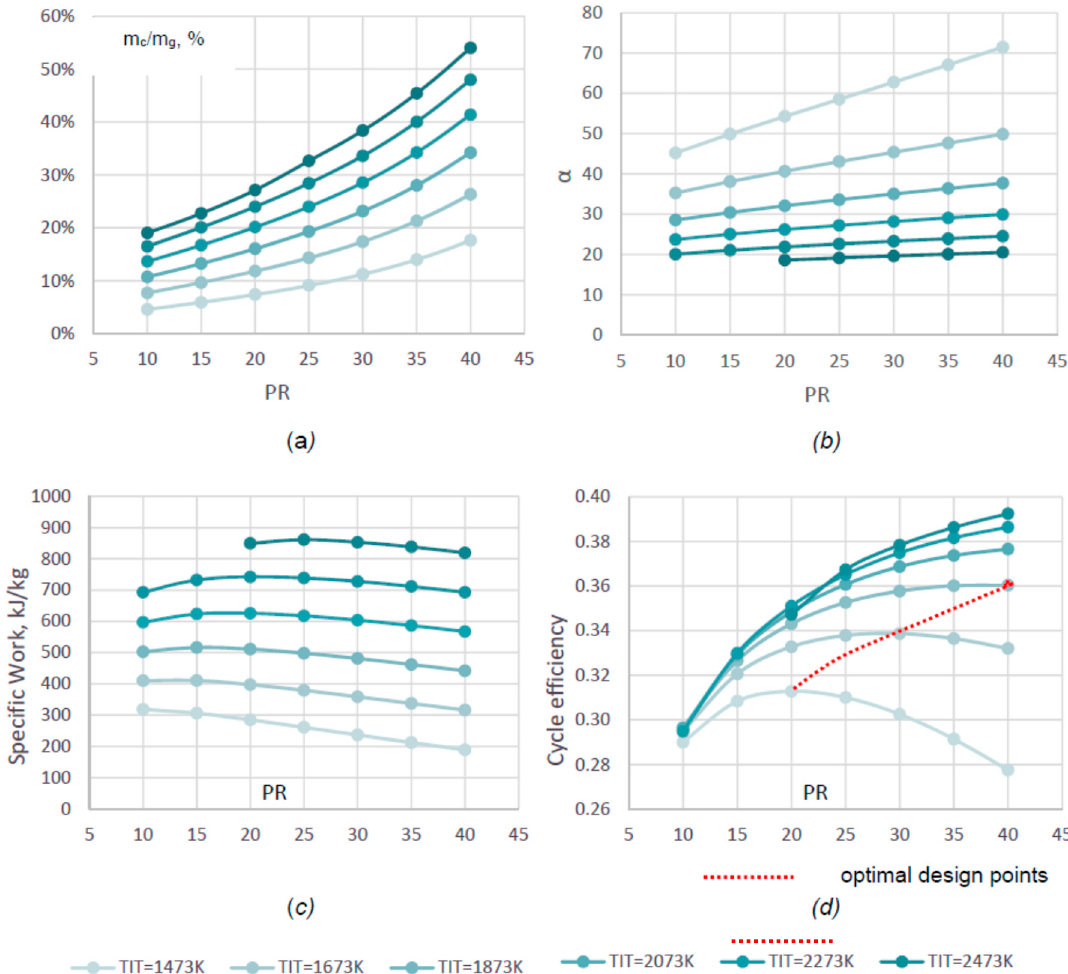
Figure 8. Cooling mass flow rates ( a ) air to fuel ratio, ( b ) specific work and, ( c ) cycle efficiency versus ( d ) TIT for increasing β max.